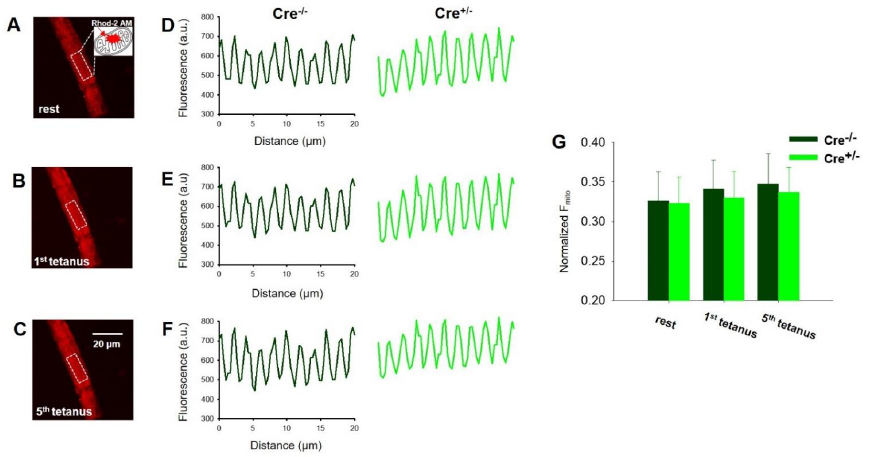
Figure 6. Unaltered activity dependent mitochondrial calcium uptake in FDB muscles from Cre +/ − mice. Representative confocal images of a Rhod-2 AM-loaded FDB fiber originated from a Cre +/ − mouse in resting condition ( A ), after the 1st ( B ), and after the 5th ( C ) tetanic stimulation. Calibration in panel ( C ) corresponds to both images shown in ( A , B ). ( D – F ) Rhod-2 fluorescence intensity profiles were calculated from similar dashed line delimitated areas as presented in panels ( A – C ) for both animal groups. ( G ) Average amplitude of Rhod-2 fluorescence intensity changes in resting condition, after the 1st and the 5th tetanic stimulation. The average ( ± SEM) change of normalized mitochondrial fluorescence ( F mito ) was calculated for n = 15–17 cells originated from 4–6 mice in each group based on Equation